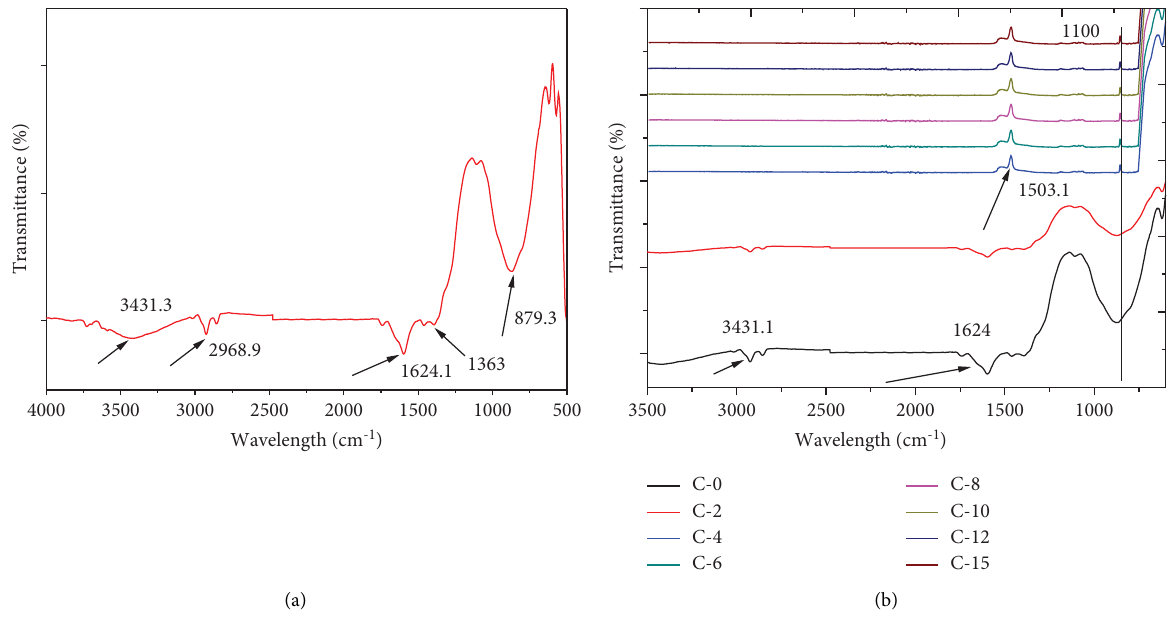
Figure 6: (a) FTIR spectra for pristine zirconia support. (b) FTIR spectra of synthesized freshly calcined